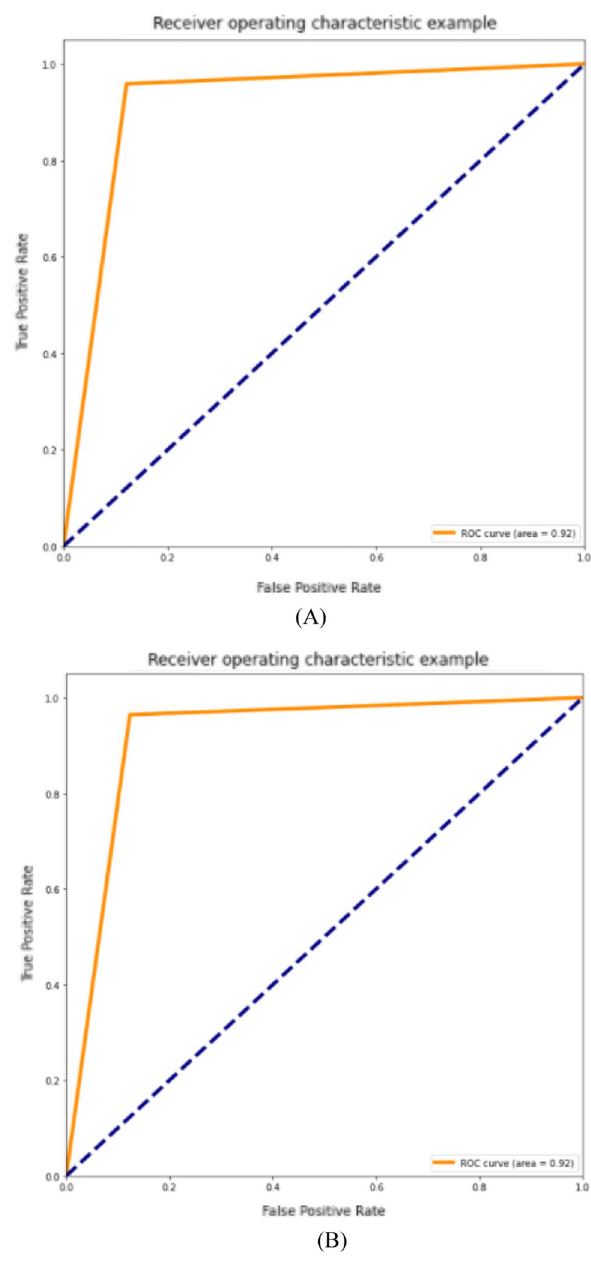
Fig. 3 AUC curves of the training set A and the testing set